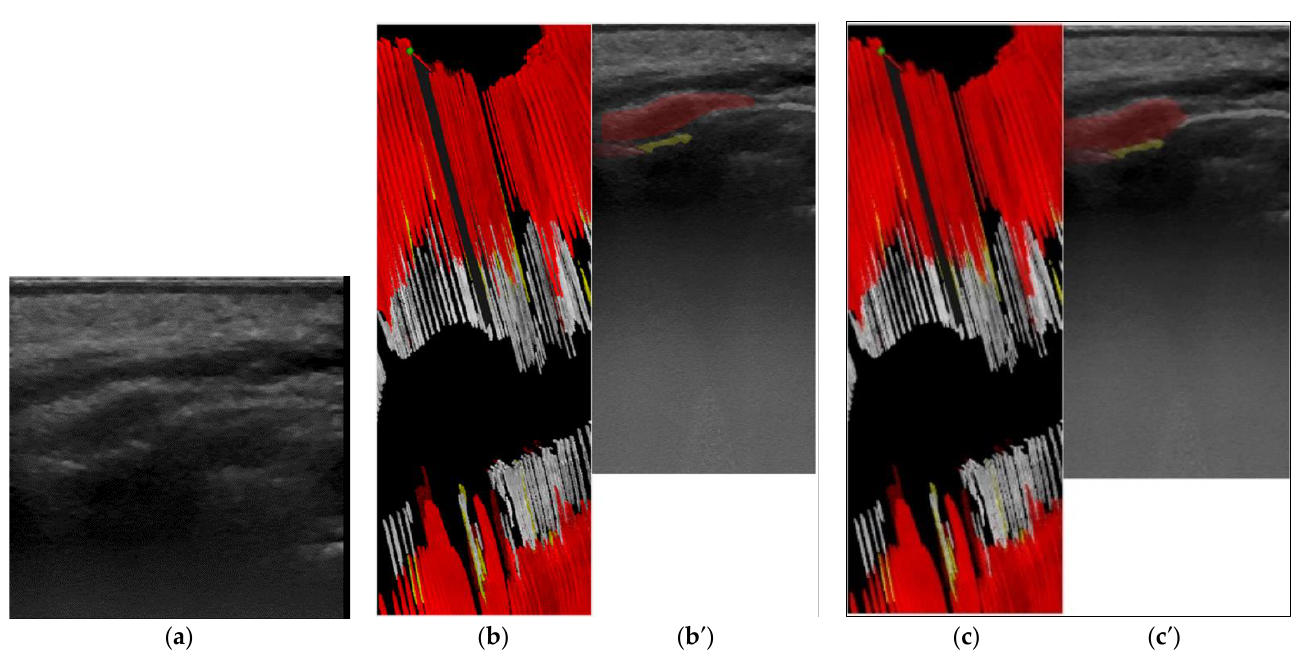
Figure 3. ( a ) 2.1, central incisor, longitudinal section of the marginal periodontal tissue, buccal surface original US image, gray scale; ( b ) 3D visualization: red—cross-sectioning plane direction orientation on X axis; ( b′ ). first semi-automatic segmentation: white — tooth crown, yellow – tooth root, dark red — gingiva, light red — cortical bone; ( c ) 3D visualization using corrected masks; ( c′ ) segmentation after correction: white — tooth crown, yellow tooth root, dark red — gingiva, light red — cortical bone.